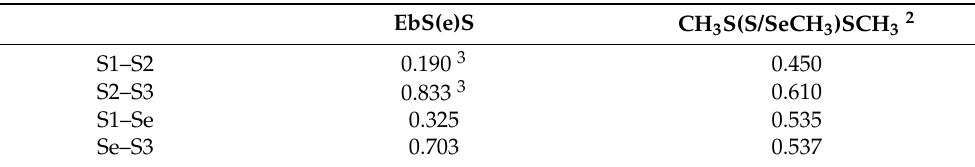
Table 1. Wiberg indexes for S1-S2-S3 1 and S1-Se-S3 1 TCIs, with EbSeS and a sulfur analogue, and for two previously described minimal models. Level of theory: B3LYP-D3(BJ)/6-311G(d,p),